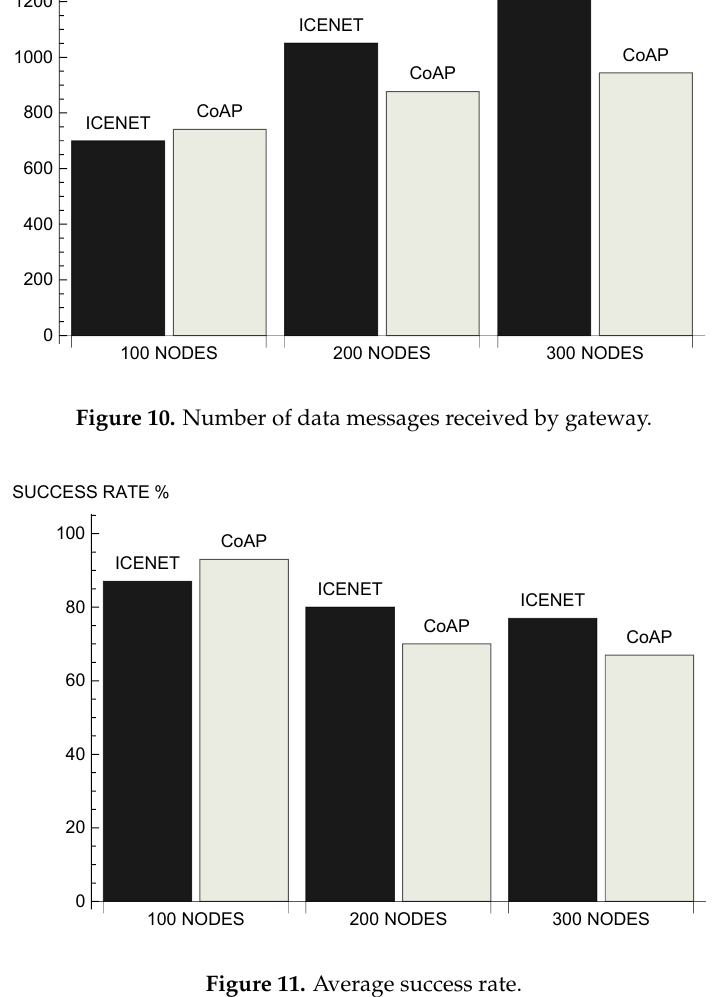
Figure 11. Average success